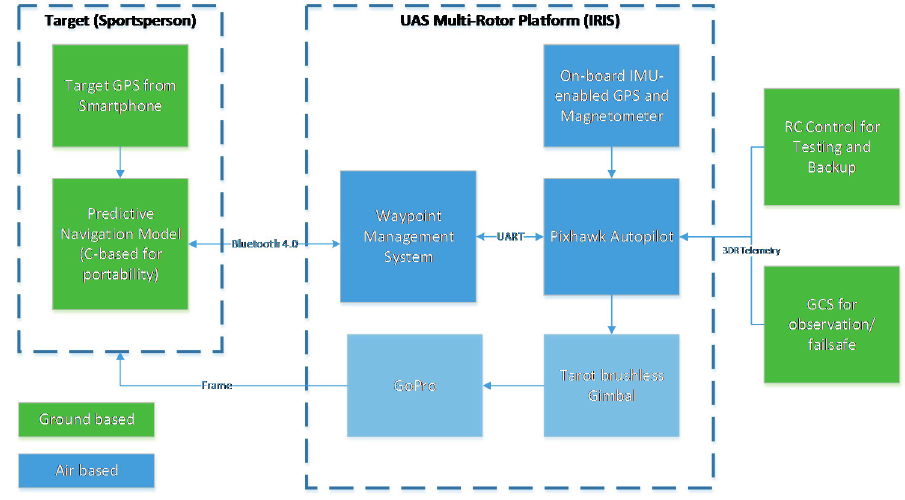
Figure 8. System architecture for the low-cost UAS.